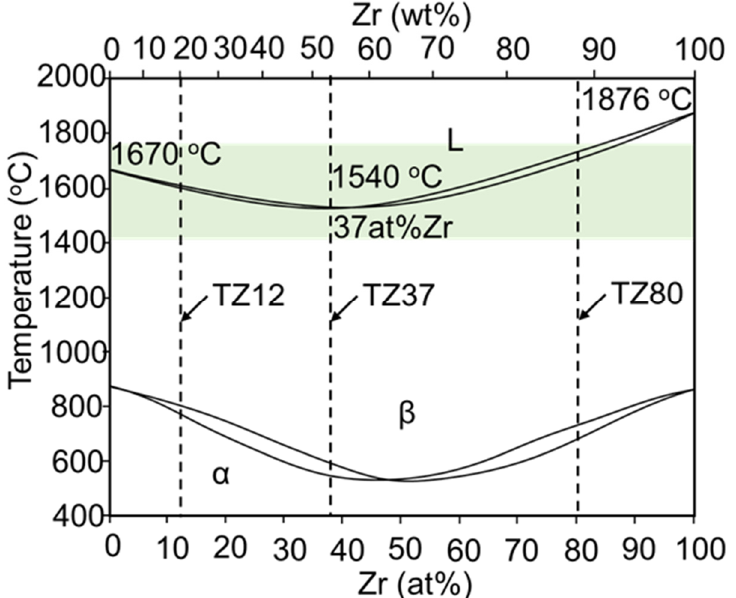
Figure 2. Phase diagram for Zr–Ti system.